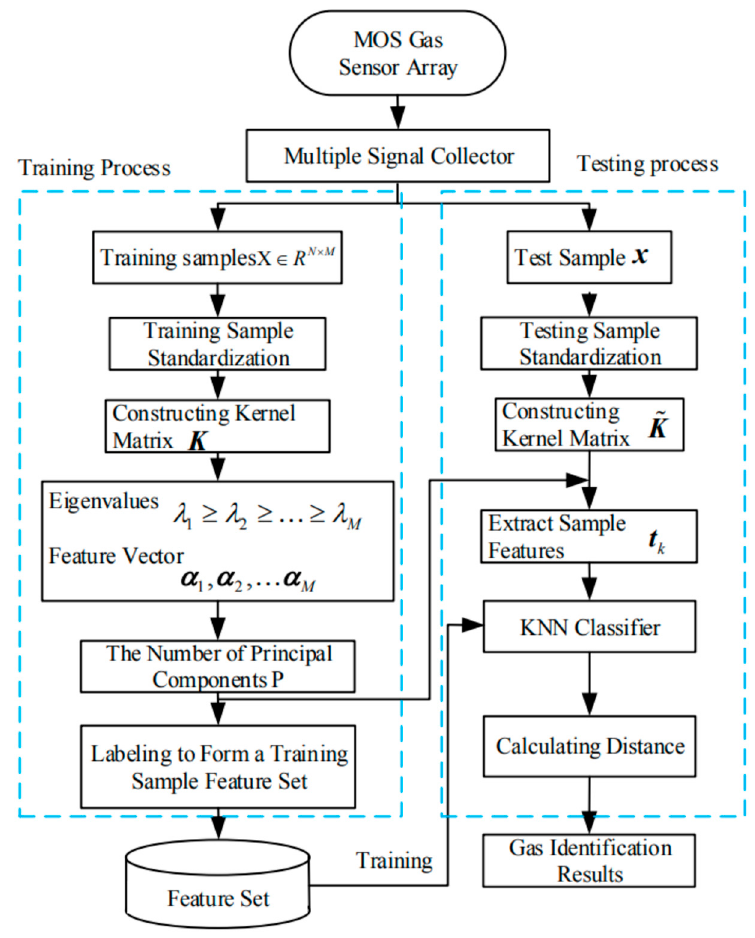
Figure 6. Flow diagram of binary mixed gas recognition method based on KPCA-KNN in 2018 [74]. (5) Decision Tree (DT)